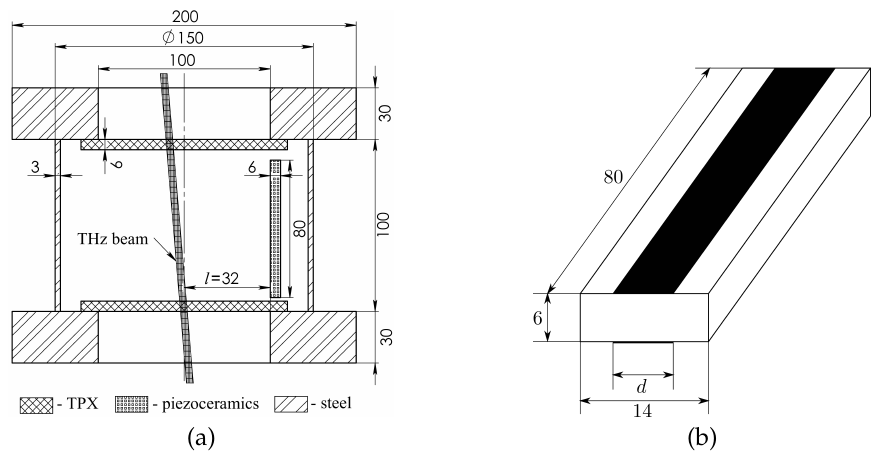
Figure 4. Schematic of THz AO modulator: ( a ) AO cell; ( b ) ultrasound transducer. The Novosibirsk free-electron laser (FEL) 1 was used as a source of monochromatic THz radiation with the wavelength λ = 130 µ m (see Figure 5). The THz beam was limited